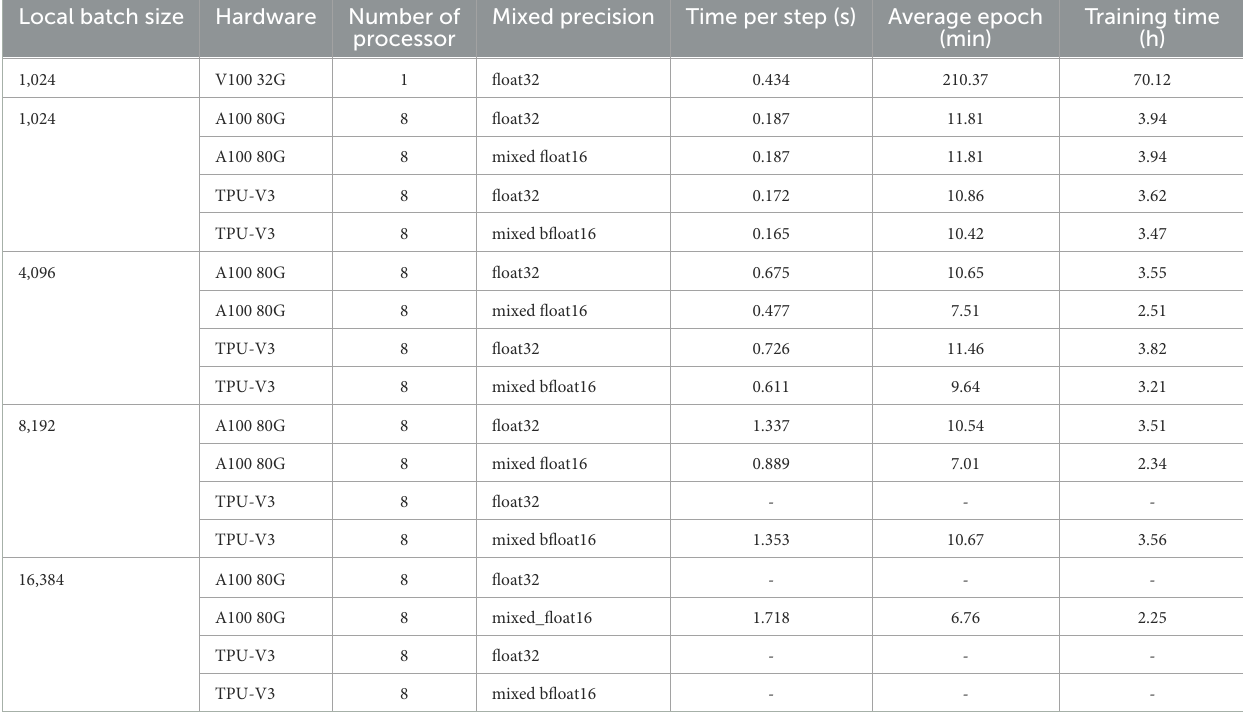
TABLE 1 Summary of training speed for different batch sizes and accelerator hardware configurations. Local batch